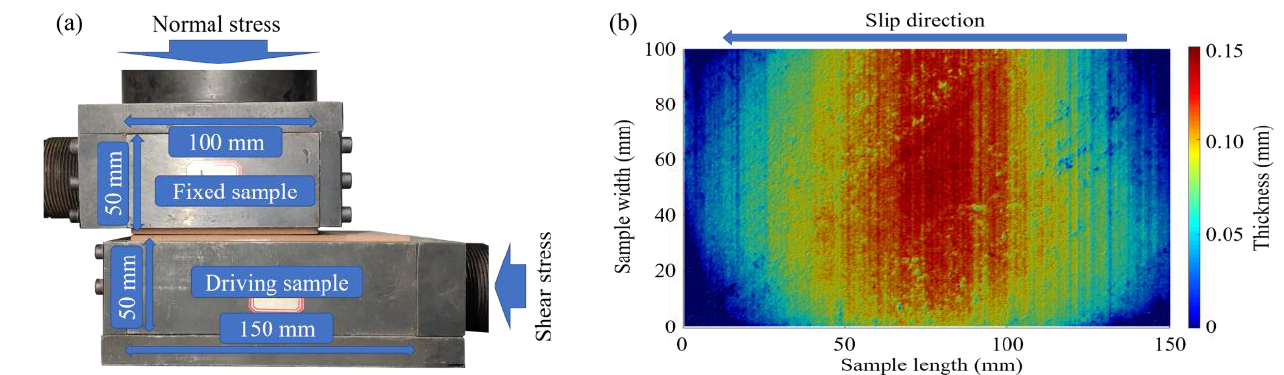
Figure 1 . Sample photographs. ( a ) Photograph and dimension of the rock samples. ( b ) Photo of the 3D laser survey of the fault surface, which was roughened with #60 silicon carbide grit sandpapers.